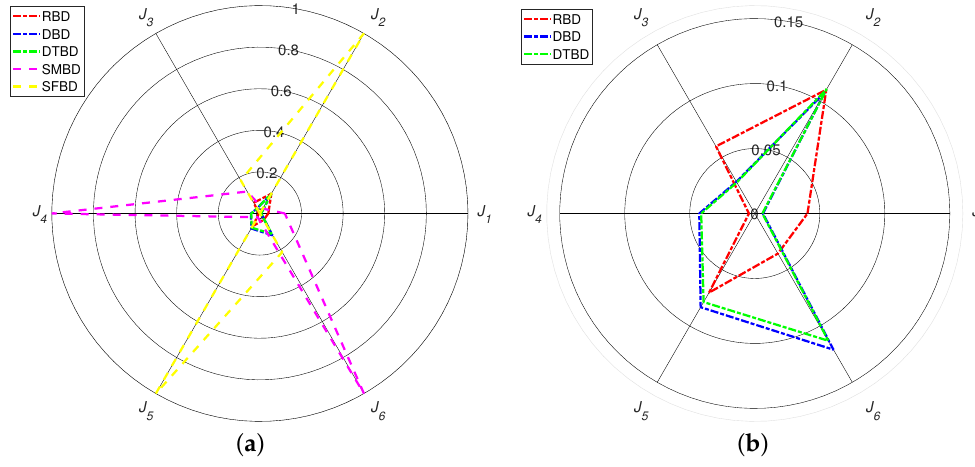
Figure 7. Performance functions of the design approaches. ( a ) Radar plot. ( b ) Close-up view. Hence, twelve different disks (different m e and I m